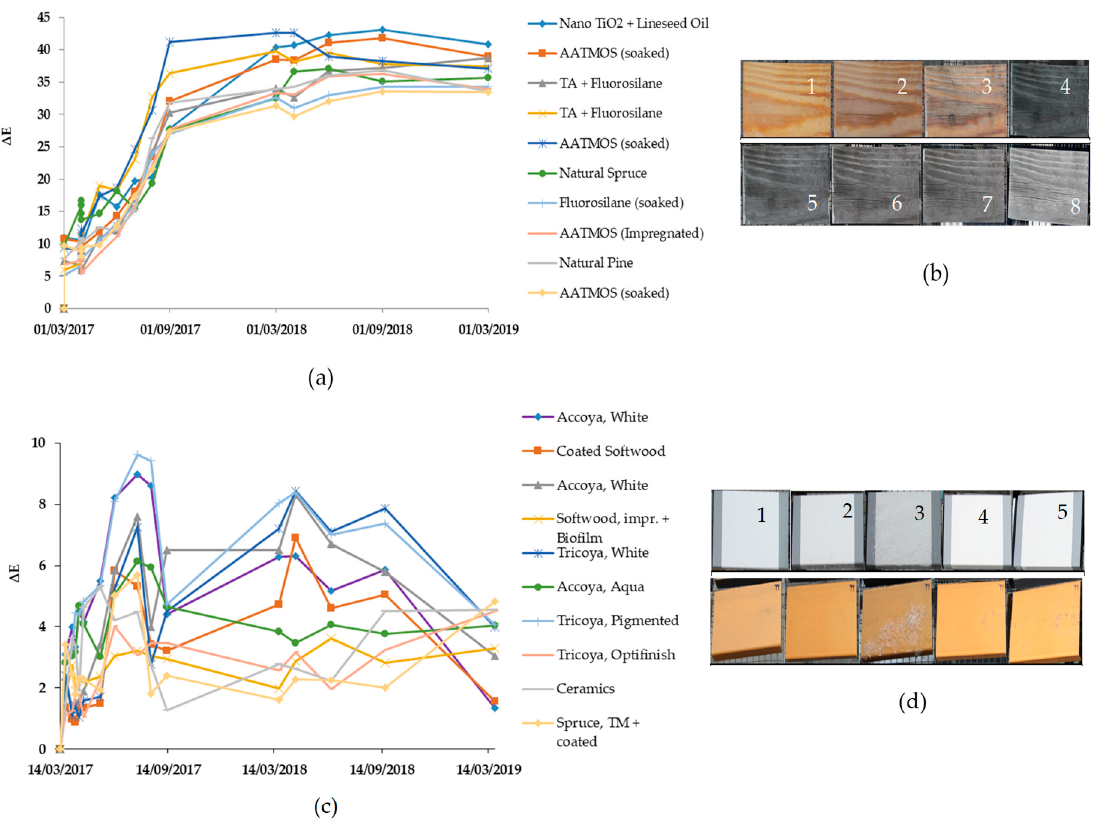
Figure Figure 6. ( a ) Ten specimens with the most colour changes, ( b ) image of titanium dioxide (TiO 2 )- impregnated + linseed-oil-treated wood taken at 3-month intervals, ( c ) 10 specimens with the least colour changes and ( d ) image of accoya (matt and pigmented white) taken at intervals of 6-month until the end of weathering [17].